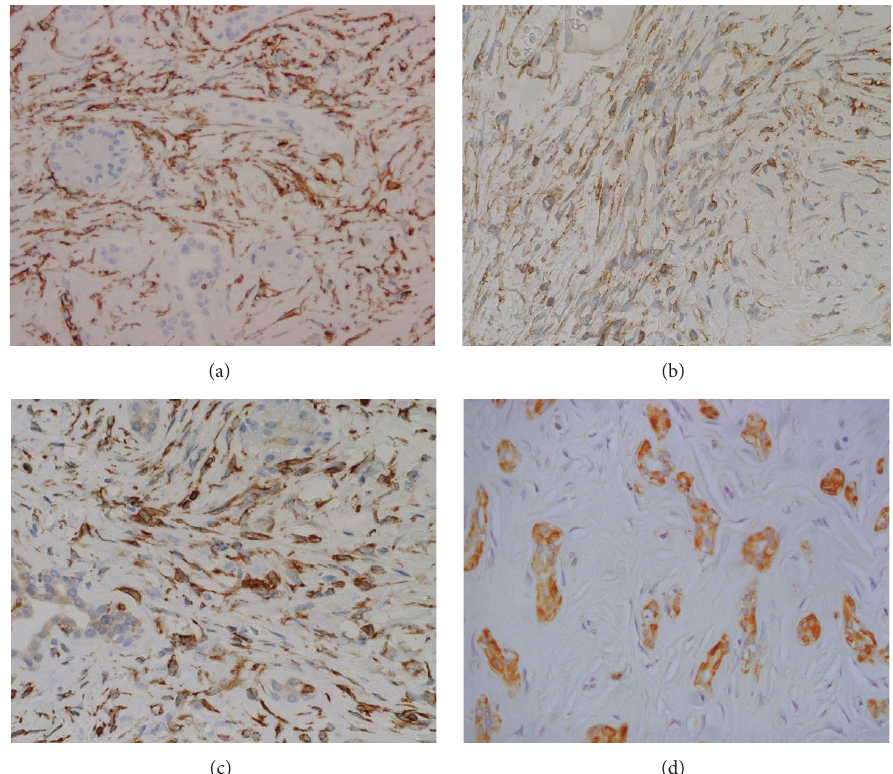
Figure 2: Spindle cells were immune-positive for (a) CD34, (b) CD99, and (c) bcl-2. (d) Ductal epithelia were immune-positive for S-100.